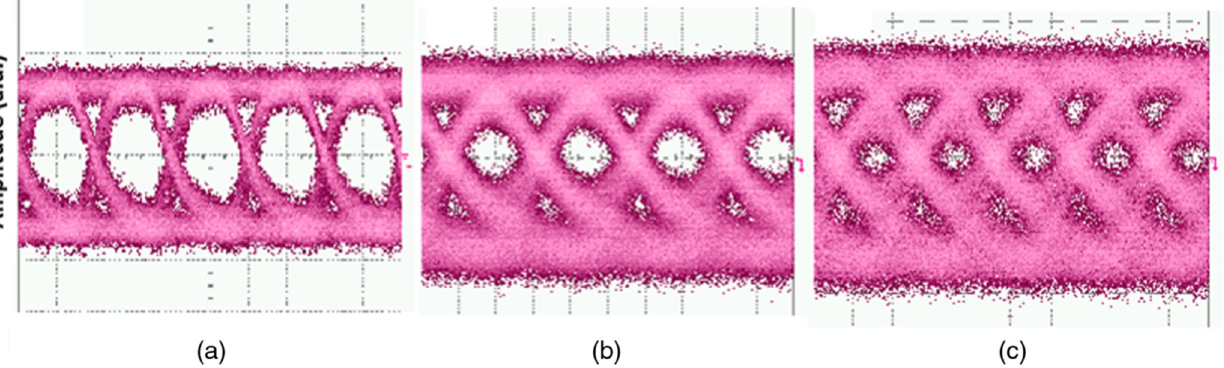
Figure 5. Eye diagrams showing data transmission for a signal transmitted through water at ( a ) 1 Gbit/s at 125 mA laser drive current, ( b ) 2 Gbit/s at 132 mA, and ( c ) 2.488 Gbit/s at 132 mA.